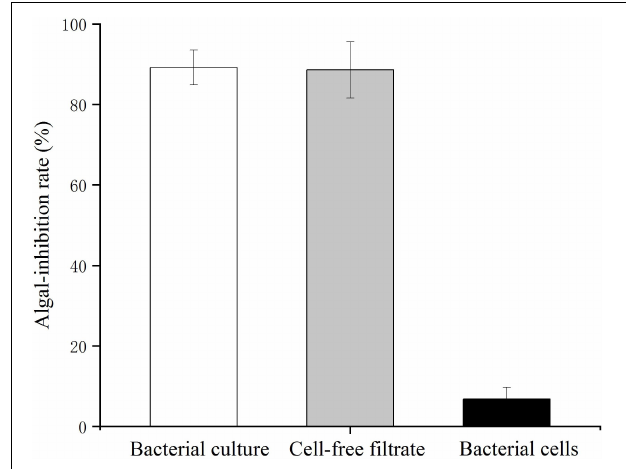
FIGURE 2 | Algicidal activities against Karenia mikimotoi by Paracoccus homiensis O-4 treatment groups (bacterial culture, cell-free filtrate, and bacterial cells). Error bars represent the standard deviation of the